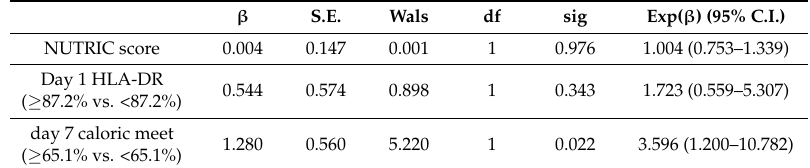
Table 3. Multivariate analysis of clinical characteristics and immune status for 28-day mortality prediction. ( n =